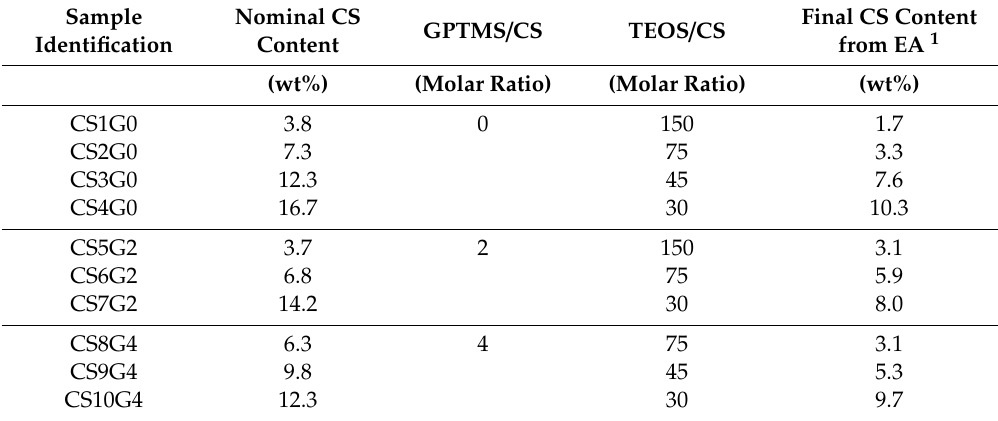
Table 1. Sample identification, starting compositions and final content of CS based on Elemental Analysis (EA) measured data for each synthesized